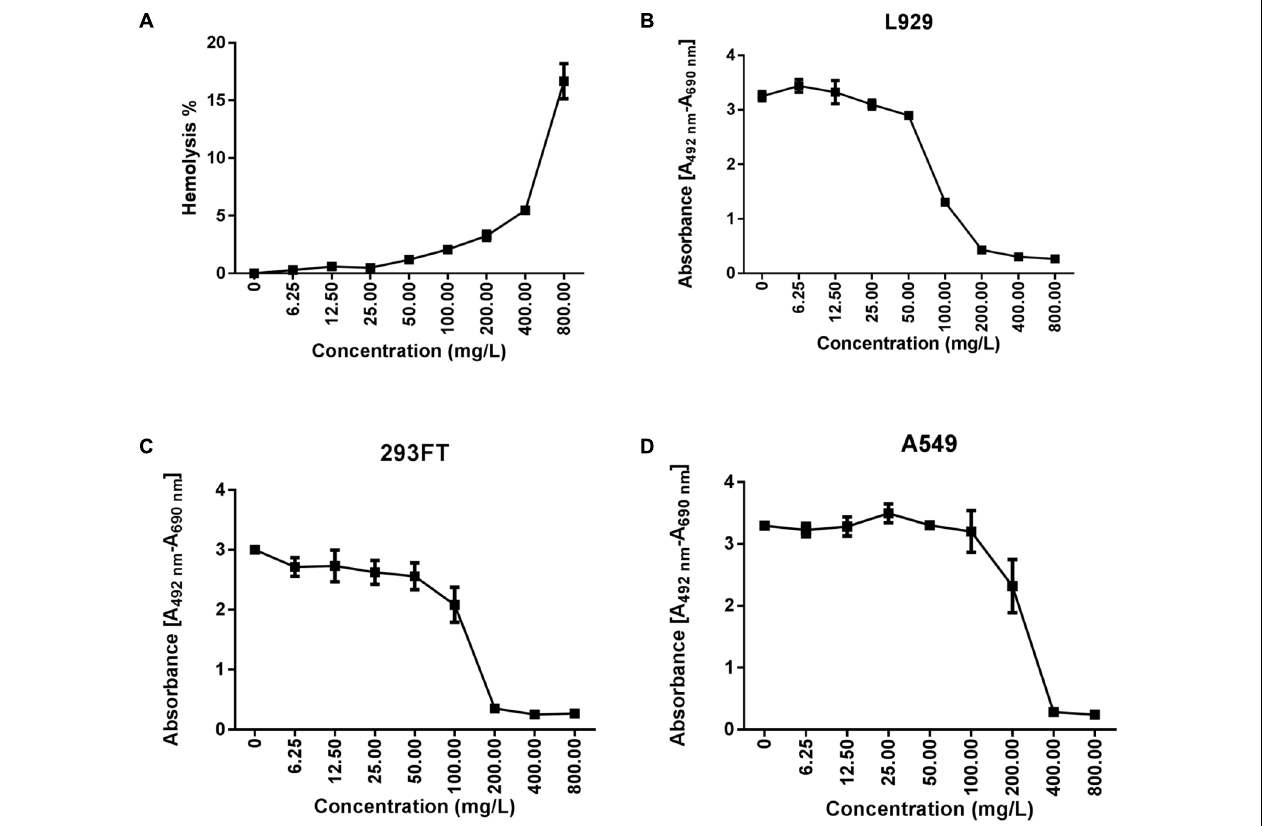
FIGURE 2 | Cytotoxicity of tachyplesin III. Cytotoxicity of tachyplesin III was tested by hemolysis and cell viability assays. (A) Tachyplesin III dissolved in 0.9% saline was added to mouse erythrocytes that were diluted with the same buffer. After 30 min of incubation at 37 ◦ C and then centrifugation at 1000 g for 15 min, supernatants were diluted 1:4 with 0.9% saline, and absorbance at 540 nm was tested. With 1% Triton X-100 (v/v) to determine 100% hemolysis and 0.9% saline as the negative control, the hemolysis rate was calculated as [(Absorbance sample − Absorbance control )/(Absorbance 100% − Absorbance control )] × 100. Cytotoxicity was assessed using the Cell Proliferation Kit II (XTT) (Roche) for (B) L929 (mouse fibroblast cell line), (C) 293FT (human embryonic kidney cell line) and (D) A549 (adenocarcinomic human alveolar basal epithelial cell line) cells. Absorbance [A492-A690 nm] was used to quantify viable